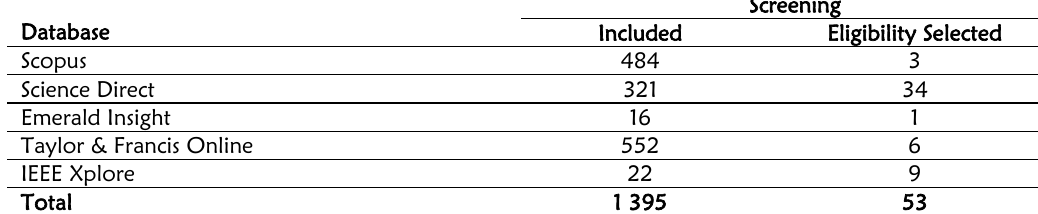
Table 6: Numbers of articles found after eligibility process